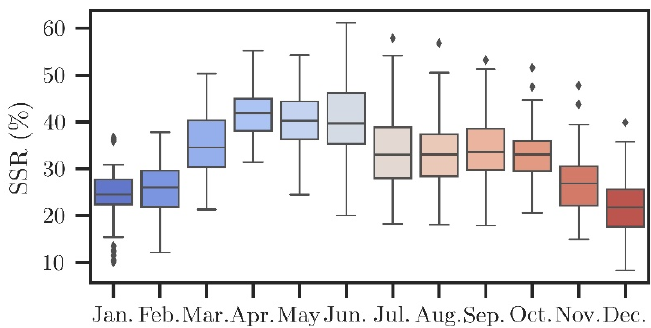
Figure 5. Monthly SSR values of the analyzed households (n = 55).